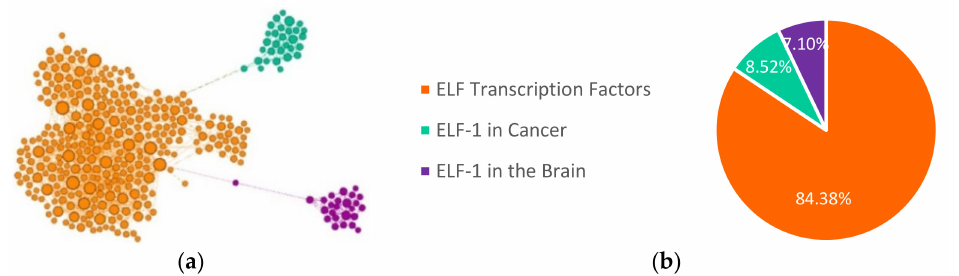
Figure 3. Representation of the ELF communities transcription factors, ELF-1 in cancer and ELF-1 in the brain. ( a ) Representation of the interaction of communities together. ( b ) Representation of the distribution of works in each